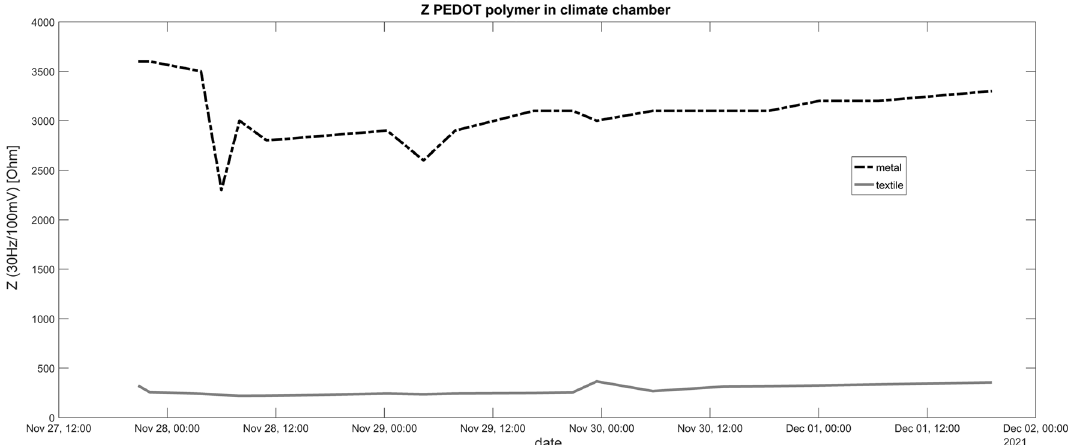
Figure 7. Impedance in the climate chamber for a period of several consecutive days. Similar to the results for resistance R, the impedance of the insulated copper wires increases more than that of the polymer cables. The impedance of the polymer cables remains below 1 kΩ over the entire period. The impedance of the copper cables (in conjunction with polymer electrodes) increases to up to 3.5 kΩ from the beginning on. Both cable types are connected with a polymer electrode.